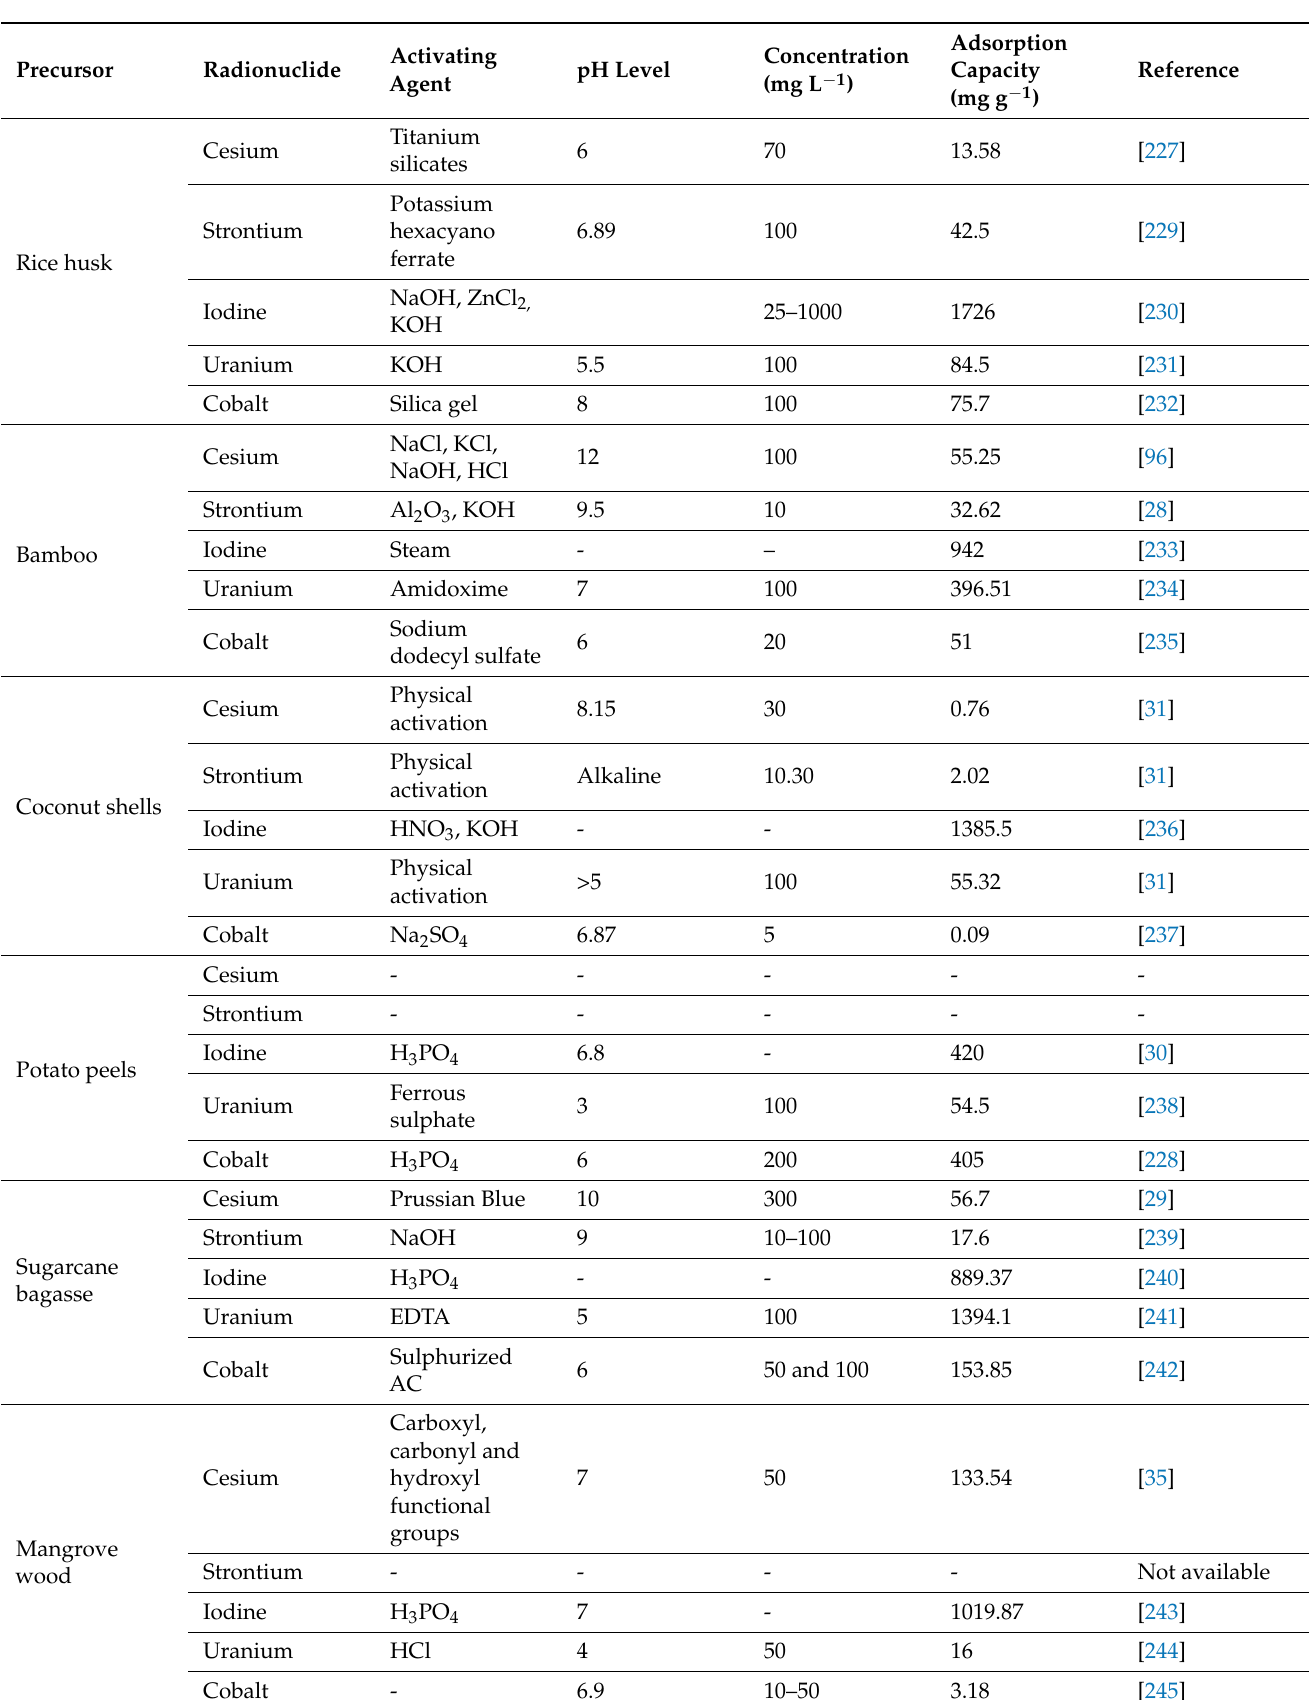
Table 8. Adsorption capacities of radionuclides onto AC prepared from several potential biomass